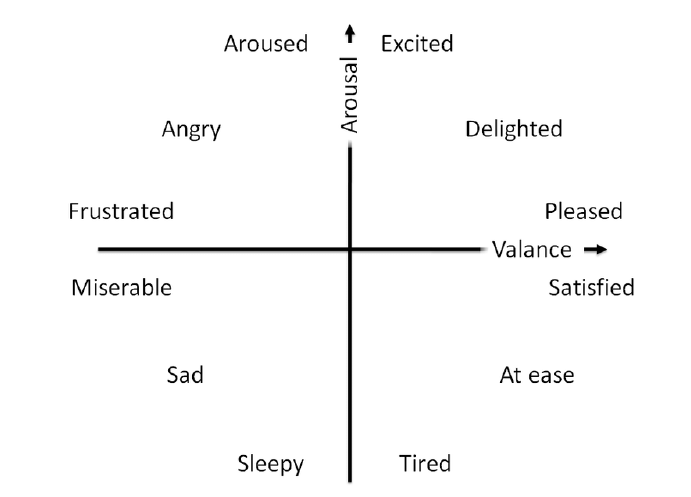
Figure 1. Russell’s circumplex model of